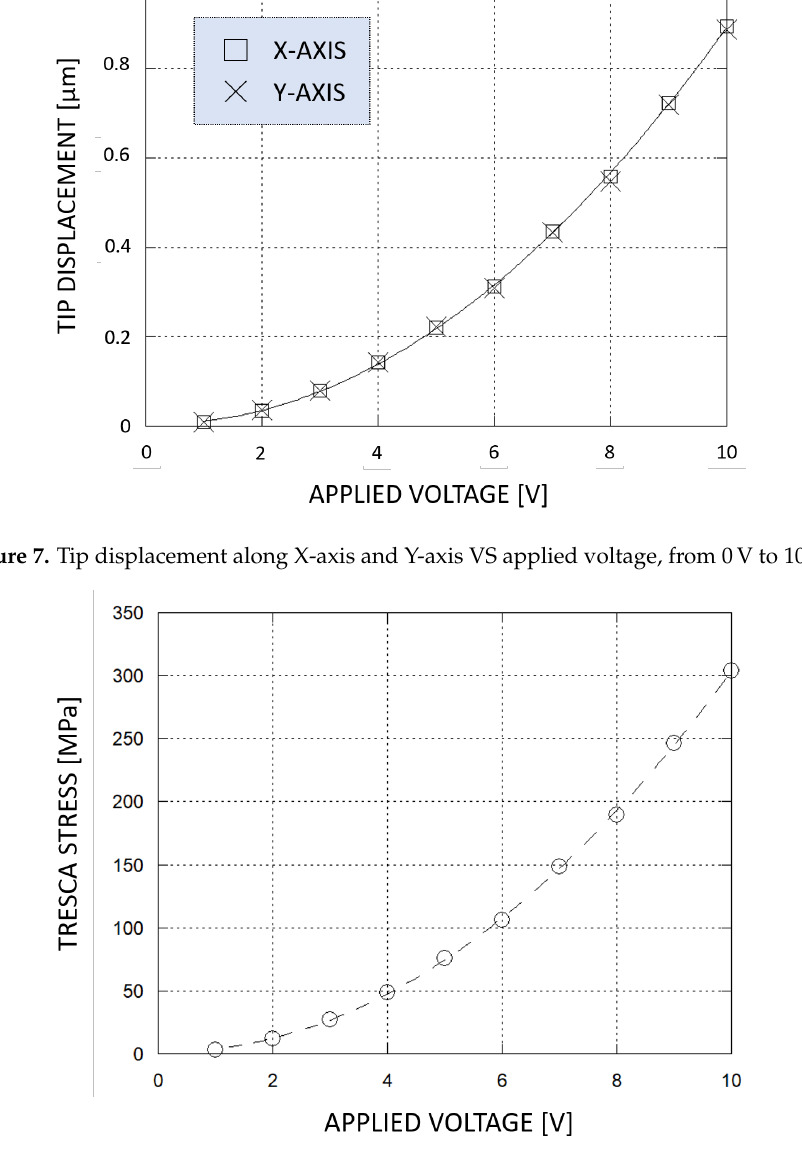
Figure 8. Tresca Stress VS applied voltage, from 0V to